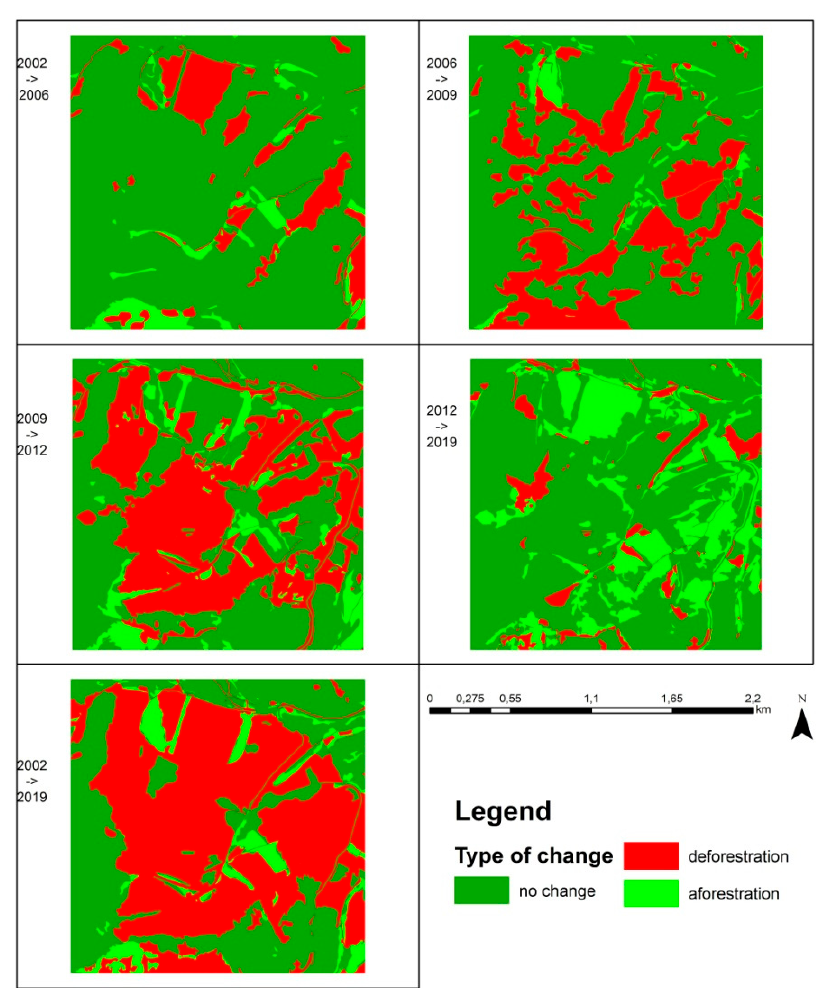
Figure 7. Land cover flows of surroundings of Č ertovica (NAPALT) . Table 8. Detailed development of land cover-changes in surroundings of Č ertovica (NAPALT).